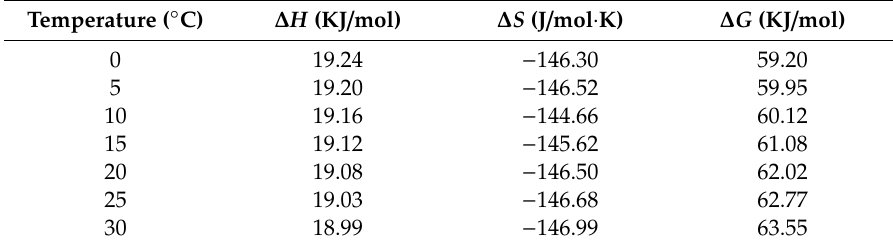
Table 4. The thermodynamic parameters of the